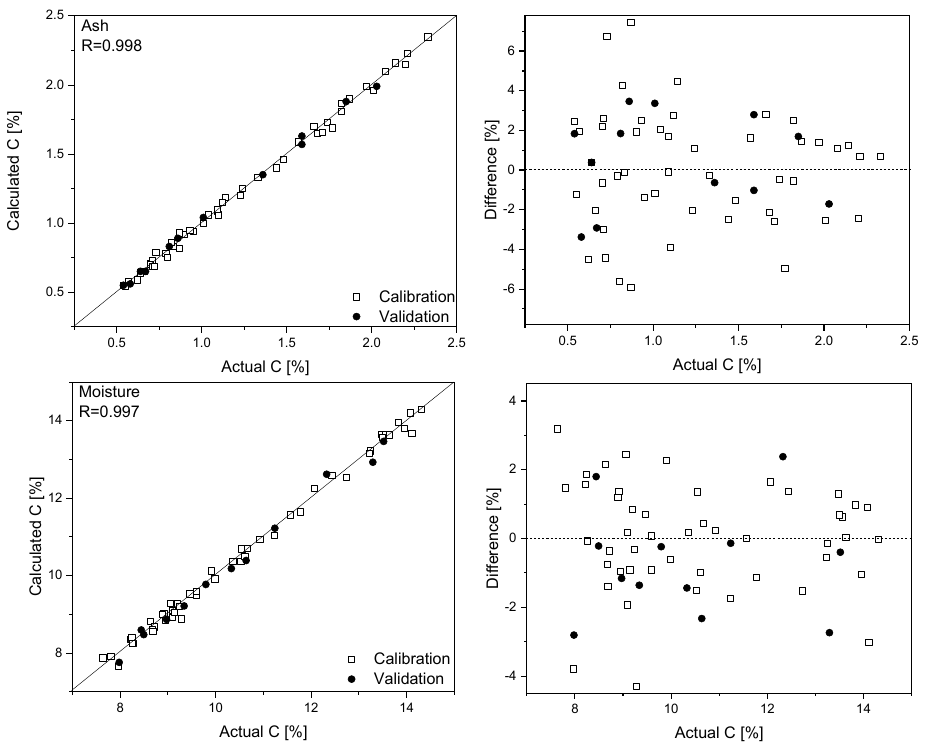
Figure 2. Prediction plots and regression residuals for ash ( top ) and moisture ( bottom ) quantification based on Raman spectra. Table 1. Calibration parameters of the PLS models for ash and moisture determination.